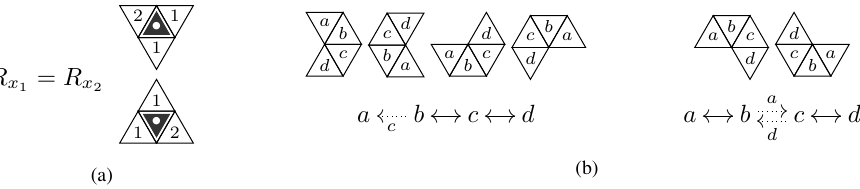
Figure 10: (a) A (2 , 4) priority strategy for the breaker for T 4 , 2 . (b) Dependency digraph of the cells in the orientations of T 4 , 2